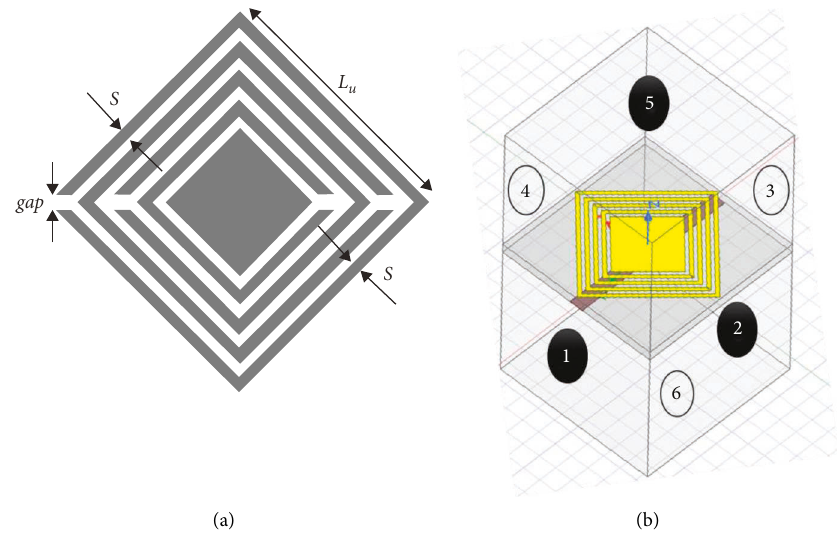
Figure 5: (a) DSCSSRs unit cell configuration, (b) Unit cell simulation setup in